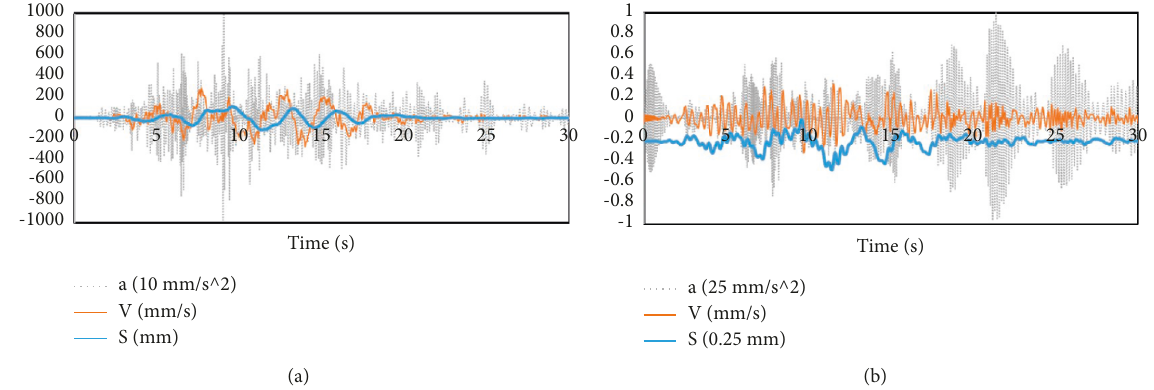
Figure 47: Time course curves of displacement, velocity and acceleration of bearing deformation when REN2 is input from X direction. (a) Horizontal deformation. (b) Vertical